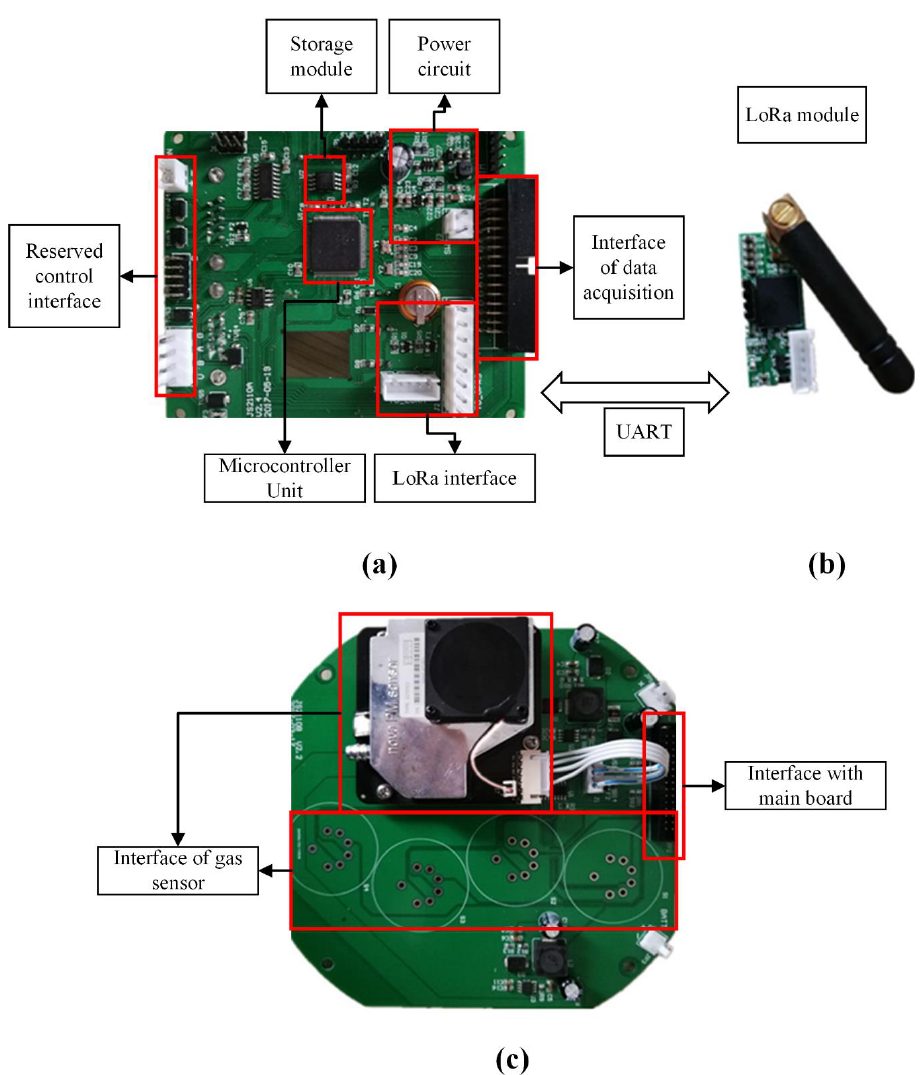
Figure 3. LoRa acquisition equipment hardware structure, consisting of three parts. ( a ) Main board, ( b ) LoRa module, ( c ) Data Collection Board. UART = universal asynchronous receiver/transmitter. ( b ) LoRa module, ( c ) Data Collection Board. UART = universal asynchronous